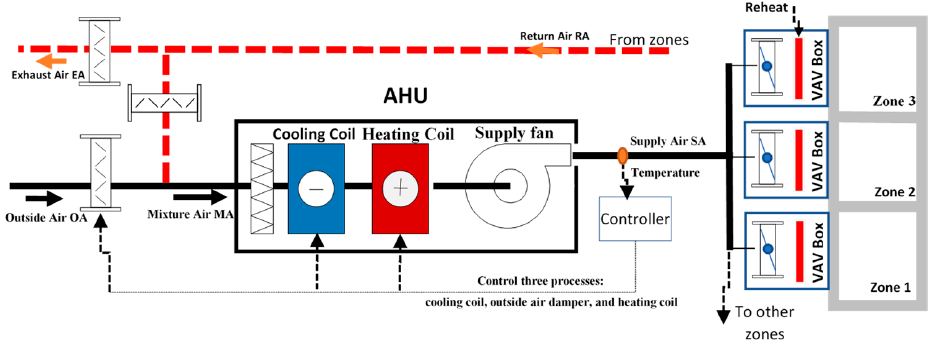
Figure 1. Schematic of a typical VAV system.